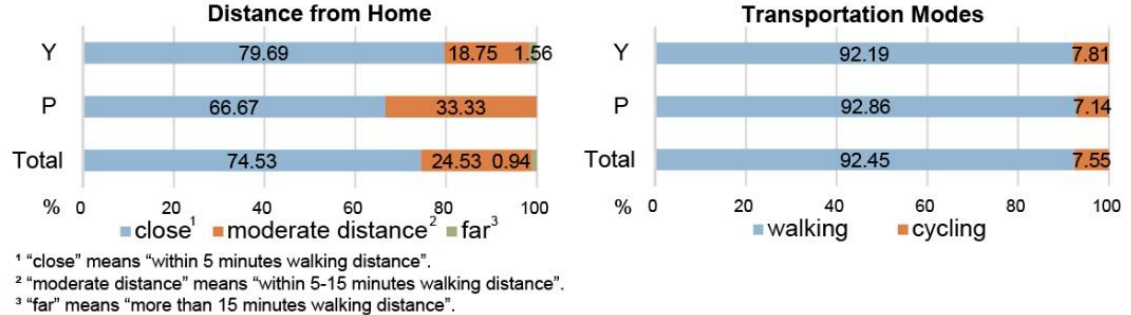
Figure 4. Survey statistics of respondents ’ spatial scale preferences.